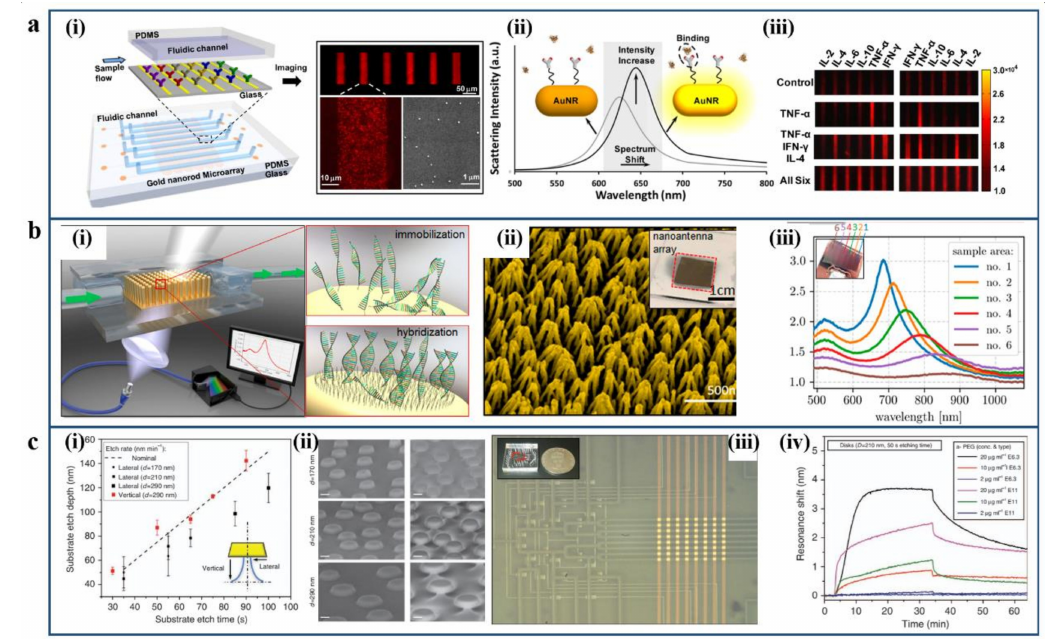
Figure 5. Examples of nanoparticle array-based plasmonic sensing platforms. ( a ) LSPR biosensor with microfluidic patterning and gold nanorods (Au NRs) conjugated with antibodies: ( i ) Schematic of the LSPR microarray chip. ( ii ) The principle of the Au NRs microarray LSPR sensing system. ( iii ) Dark-field images of Au NR microarrays for multiplex cytokine detection. Reproduced with permission from [91]. Copyright 2015 American Chemical Society. ( b ) Vertical arrays of gold nanoantennae-based plasmonic biosensor: ( i ) Schematic of vertical arrays of a gold nanoantennae-based plasmonic biosensor, which is incorporated into a microfluidic chip system. ( ii ) SEM image of vertically aligned nanoantennae. ( iii ) Extinction spectra of vertically aligned nanoantennae. Reproduced with permission from [92]. Copyright 2018 American Chemical Society. ( c ) The LSPR label-free biosensor chip based on electromagnetic decoupling: ( i ) Etch depths with vertical (red) and lateral (black) of glass for substrates covered with gold nanodisks. ( ii ) The SEM images of an LSPR substrate consists of gold nanodisks centered on narrow SiO2 pillars. ( iii ) The photograph LSPR sensor integrated with PDMS microfluidic device containing 64 sensing sites. ( iii ) ( iv ) Real-time sensorgram comparing the interaction of two types of anti-PEG IgGs with different antibody concentrations. Reproduced with permission from [93]. Copyright 2017 Spring